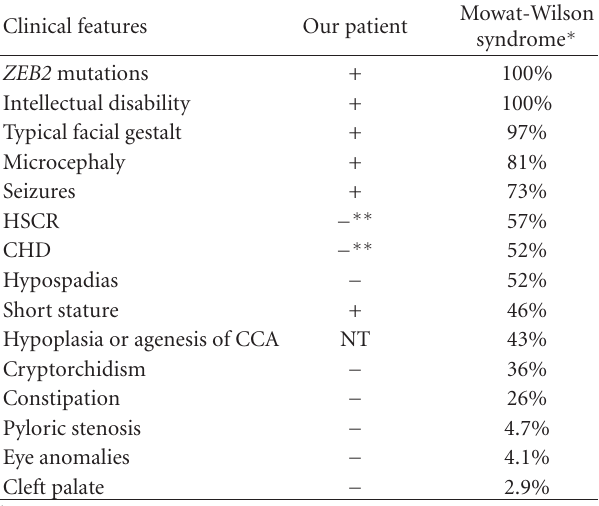
Table 1: Clinical features of our patient compared to those in published cases of MWS with proven ZEB2